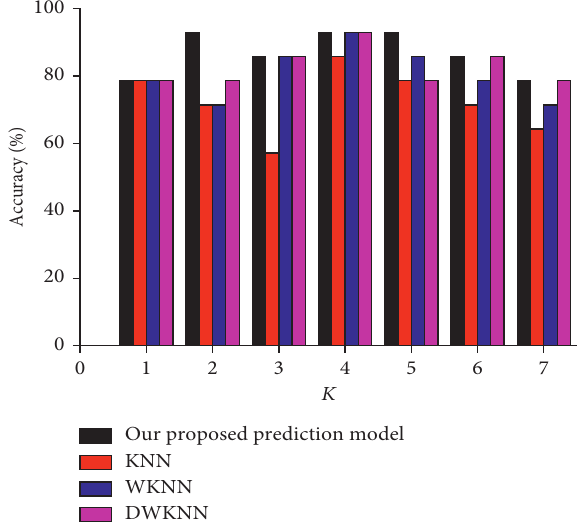
Figure 3: Slope stability prediction results with different neigh- borhood